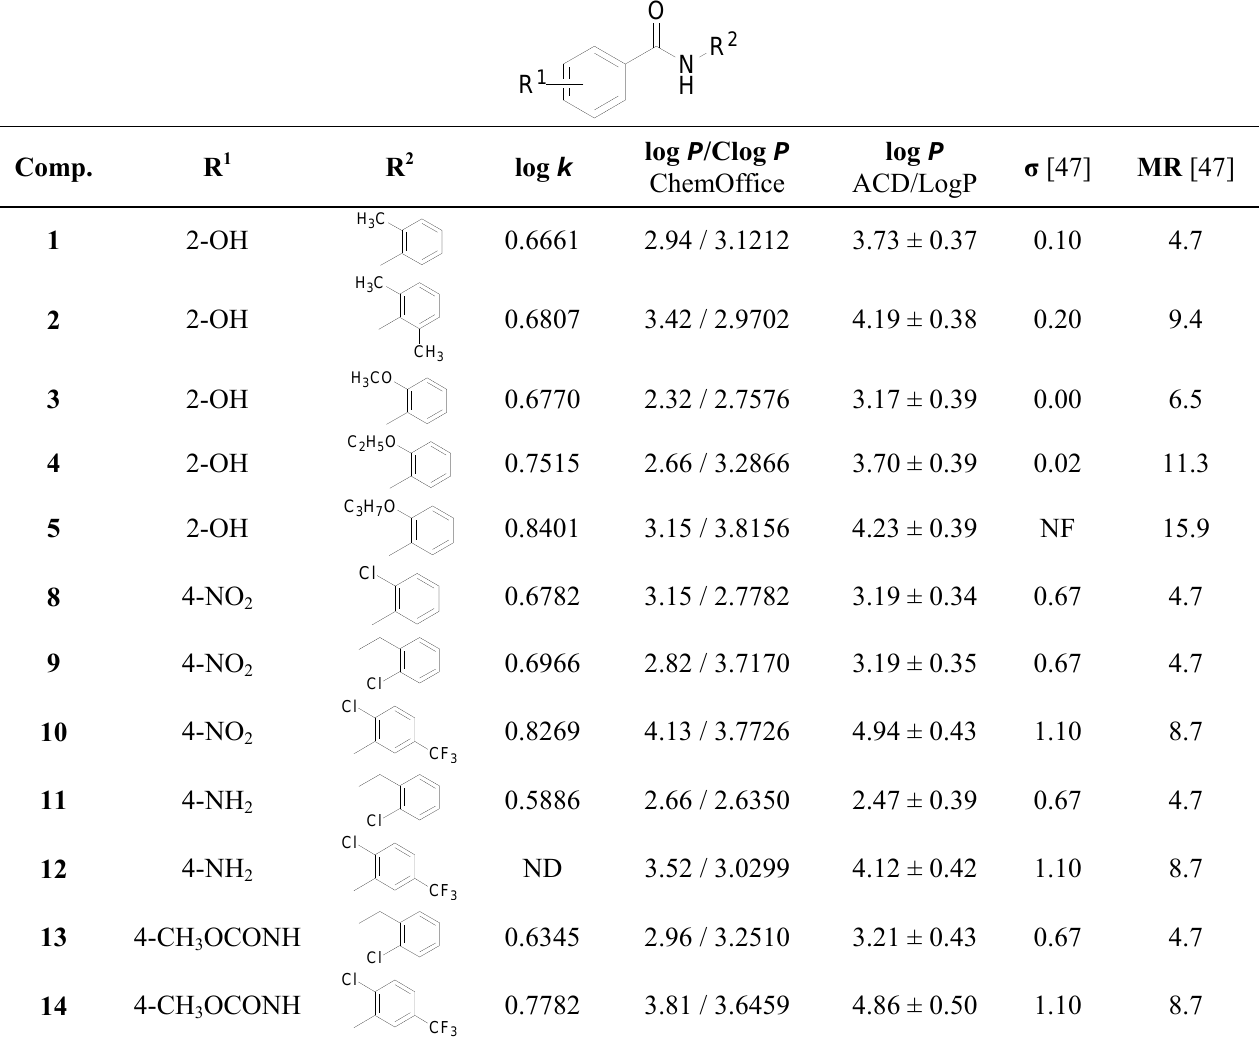
Table 1. Comparison of the calculated lipophilicities (log P /Clog P ) with the determined log k values, Hammett's parameter ( σ ) and bulk parameter (MR, reflecting bulkiness).